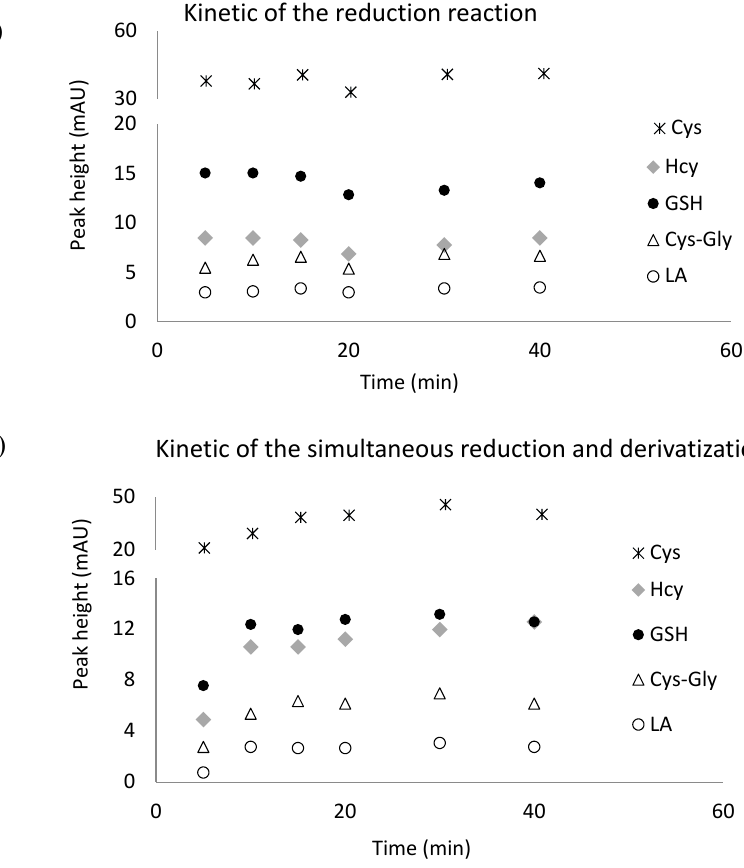
Figure 5. The influence of time on the reaction yield of tris (2-carboxyethyl)phosphine with disulfides and simultaneous reduction and derivatization reactions yields of tris (2-carboxyethyl)phosphine and 1-benzyl-2-chloropyridinium bromide with α -lipoic acid, oxidized glutathione, cystine, cysteinylglycine and homocystine. ( a ) Separate reactions of reduction and derivatization; ( b ) simultaneous reduction and derivatization reactions. Reactions carried out in 0.2 mol L − 1 , phosphate buffer, pH = 7.8.